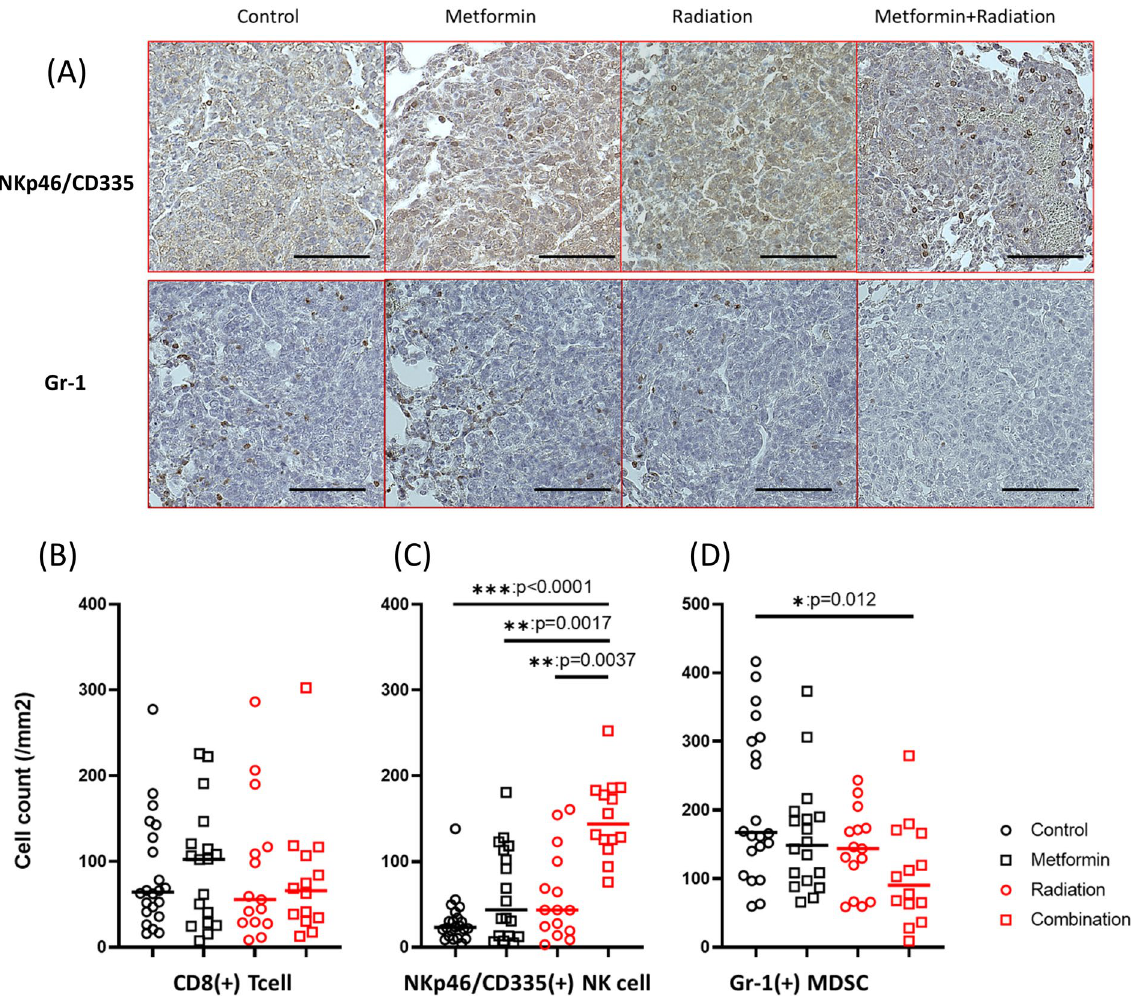
Figure 8. Immune cells in metastatic lesions in lung. Tissue specimens from the lungs excised at day 28 were immuno-stained with antibodies to CD8a, NKp46/CD335, or Gr-1(Ly-6G/Ly-6c) as described in Materials and Methods. ( A ) Representative immunohistochemistry of NKp46/CD335 (upper) and Gr-1 (lower) in metastatic lesions from the lung of the 4 groups. Black bars are 100 µm long. Densities of CD8(+) T cells ( B ), CD335(+) NK cells ( C ) and Gr-1(+) MDSC ( D ) infiltrating metastatic lesions in the lung. In each tissue section, the number of positively stained cells were determined in randomly selected 1–5 different metastatic lesions with more than 40,000µm 2 area using ImageJ software. (total: 22 lesions in control, 19 in metformin, 15 in RT and 14 in combination groups). * p < 0.05, ** p < 0.01, *** p <